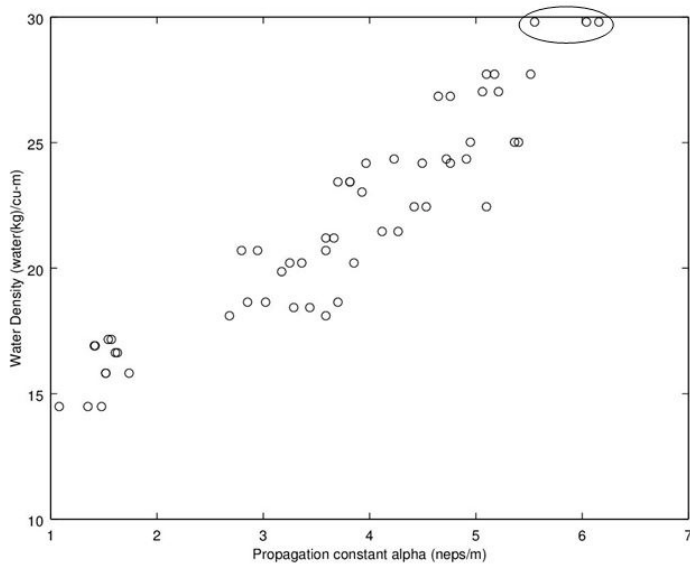
Figure 15. Graph detailing propagation attenuation constant, α versus bulk water density at 2.0 GHz. Of particular note is that at 2.0 GHz all the readings from the excessively wet low-density module are co-aligned (when they were not at the lower frequencies). The points associated with the excessively wet low-density module are circled. Note water density calculated from moisture content utilizing Equation (9).